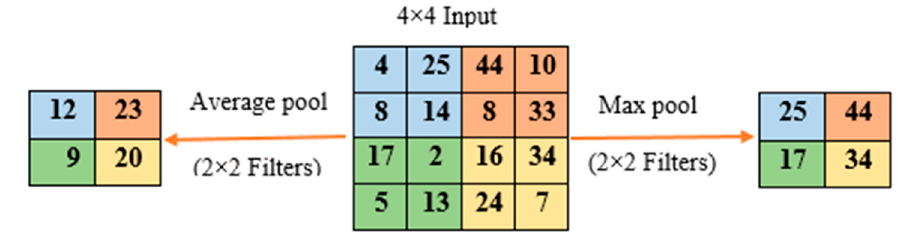
Figure 3. Two types of pooling operations.